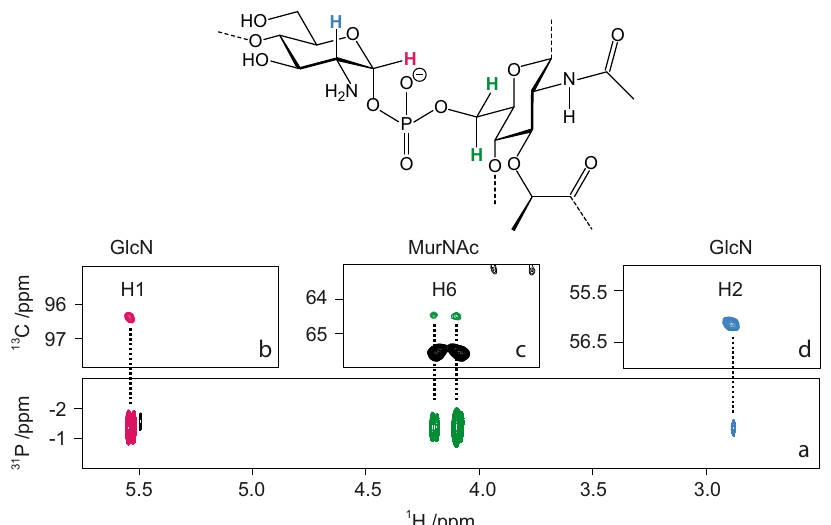
Fig. 3 Chemical structure of the GAC-peptidoglycan linkage region determined by NMR analysis. Representative structure of the linkage region of GAC anchored to the peptidoglycan layer (top). 1 H, 31 P-HMBC NMR spectrum ( a ) with a 90 ms delay for the evolution of long-range J couplings shows the key correlation between proton H1 ( b ) and H2 ( d ) of GlcN, and the two protons in position 6 of MurNAc ( c ) to a unique 31 P signal at − 1.35 ppm, characteristic of a phosphodiester linkage between the two residues. b – d Show the corresponding signals in the multiplicity-edited 1 H, 13 C-HSQC NMR spectrum. The two H6 signals of MurNAc were observed in opposite phase due to the multiplicity selection.